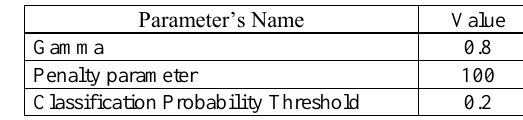
Table 2. SVM parameters for SPOT image classification